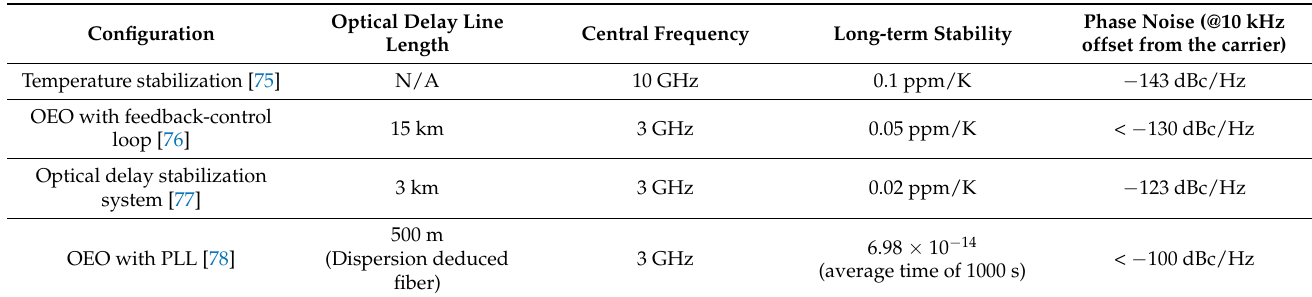
Table 2. Comparison of the different techniques to achieve long-term stability in the